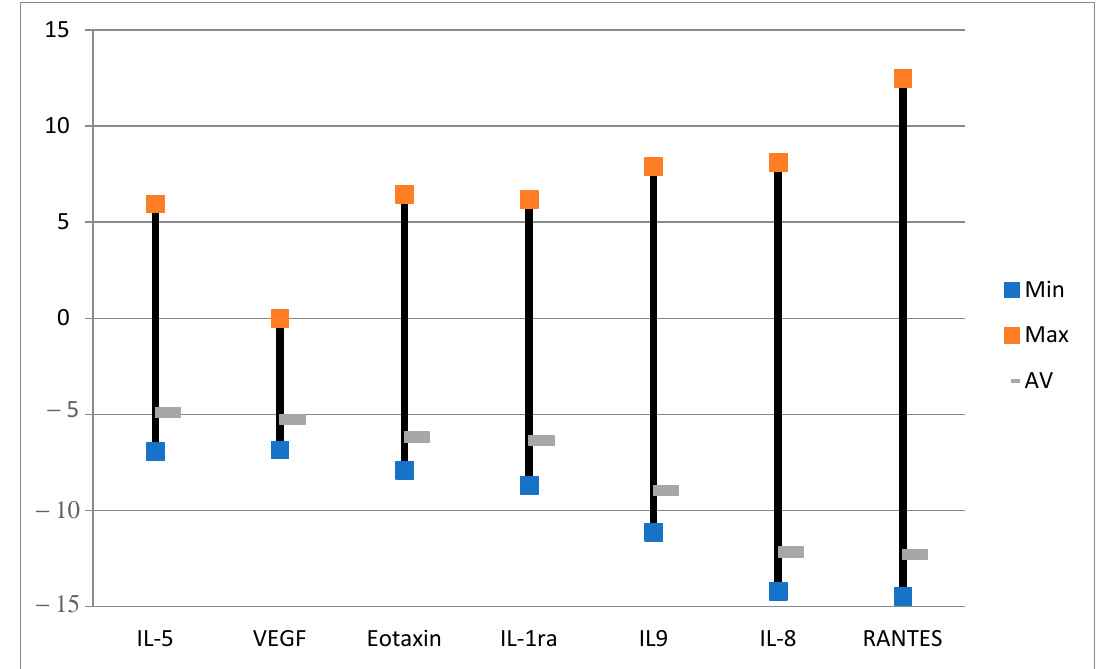
Figure 4. Effects of ALA alone on selected cytokines with the lowest variabilities. The data are presented as minimal, maximal, and average log values. Log = sgn (ALA i − Ctrl i )*log 2 (|ALA i − Ctrl i |), where ALA i is the cytokine fluorescence intensity in the group with ALA alone and Ctrl i is the cytokine fluorescence intensity in the control group with no ALA or light.